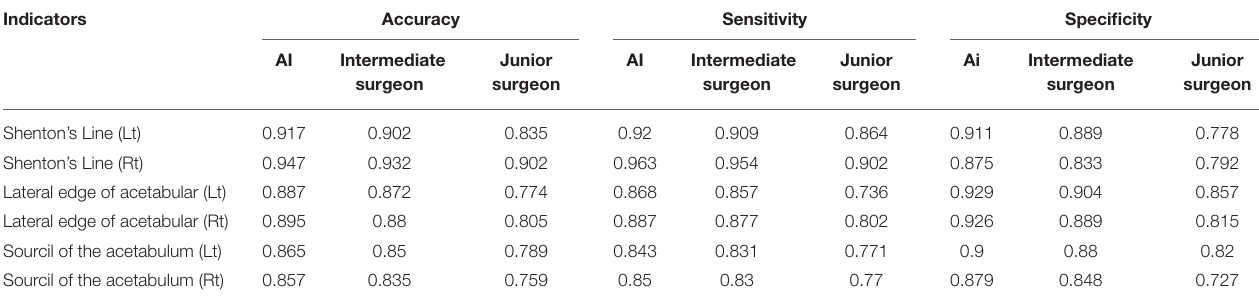
TABLE 2 | The accuracy, sensitivity, specificity, and missed diagnosis rate of six indicators in the artificial intelligence (AI) system, intermediate surgeon, and junior surgeon [Shenton’s line (Lt), Shenton’s line (Rt), lateral edge of acetabular (Lt), lateral edge of acetabular (Rt), sourcil of the acetabulum (Lt), sourcil of the acetabulum (Rt)].